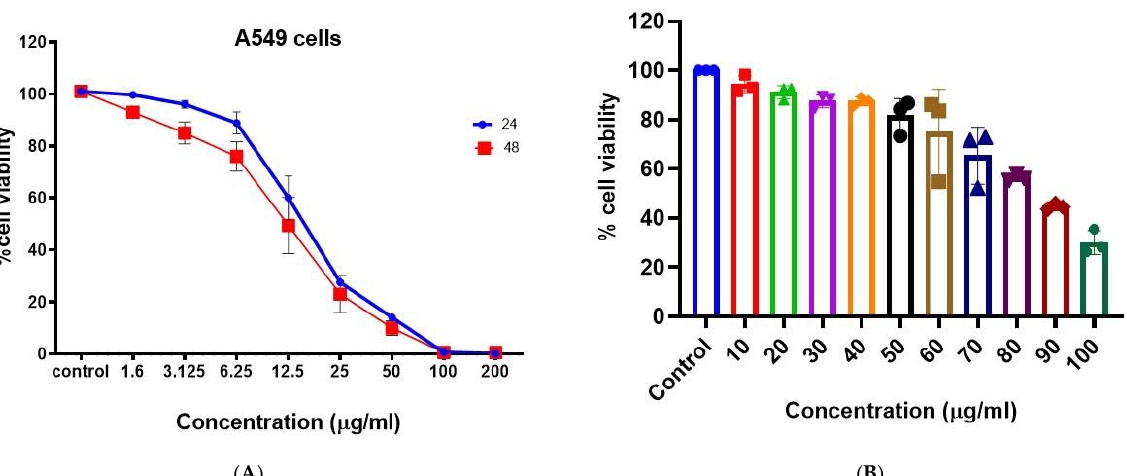
Figure 4. In vitro cytotoxicity of BAgNPs at different drug concentrations on the ( A ) A549 cells for 24 h and 48 h and ( B ) PBMCs for 24 h.